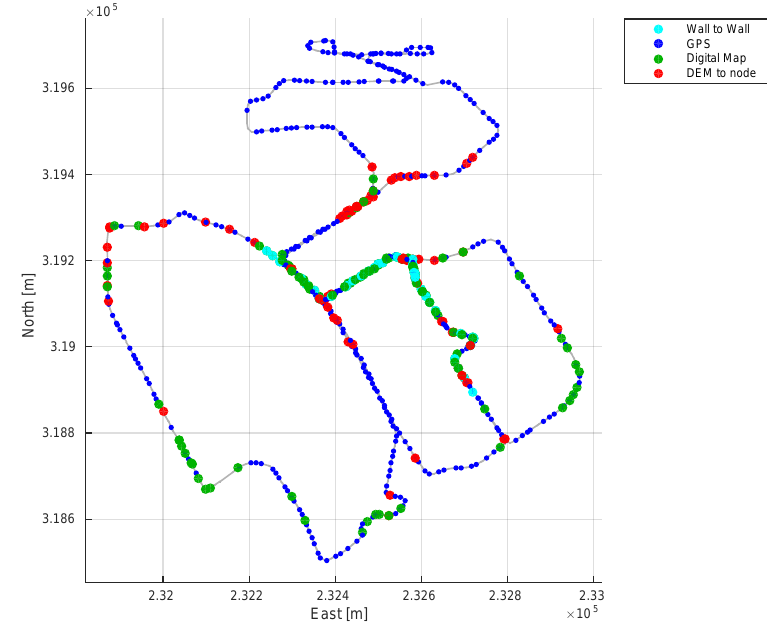
Figure 14. Sensor availability graph. The nodes are colored by the sensor type associated with the node. Blue dots are the GPS nodes and are in a smaller size for clear visualization for digital map nodes (green and red). Cyan nodes are loop-closure nodes via LiDAR